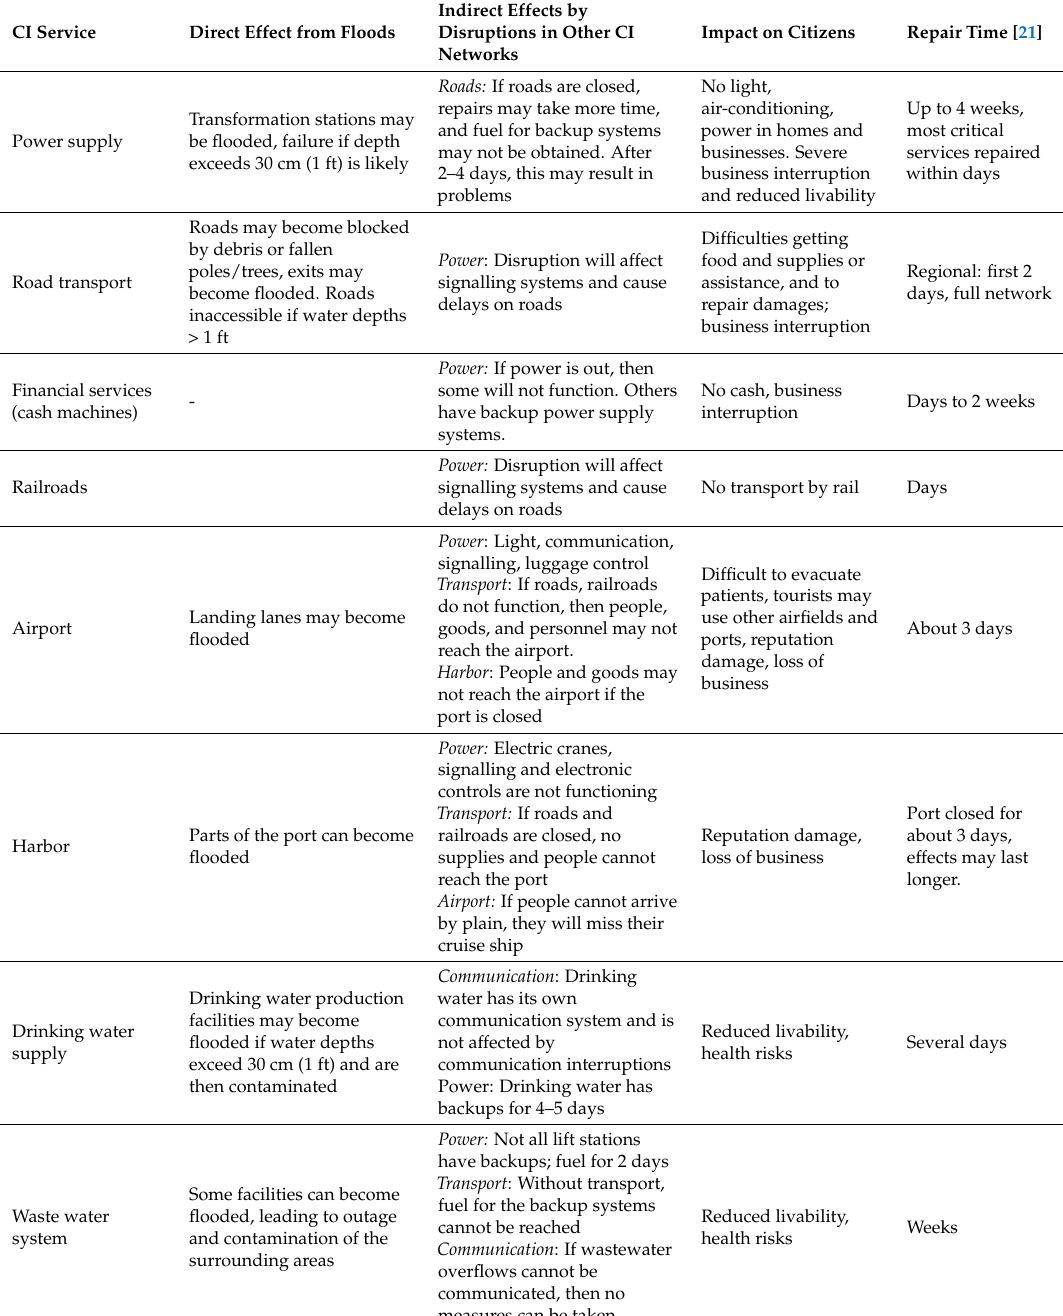
Table A1. Critical infrastructure thresholds for direct impacts, indirect flood impacts, and repair